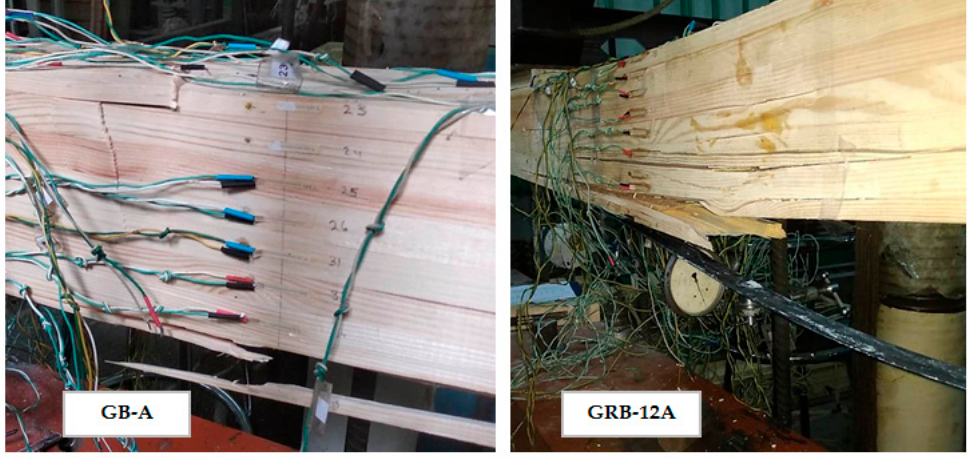
Figure 8. Fracture pattern of GB-A and GRB-12A beams.